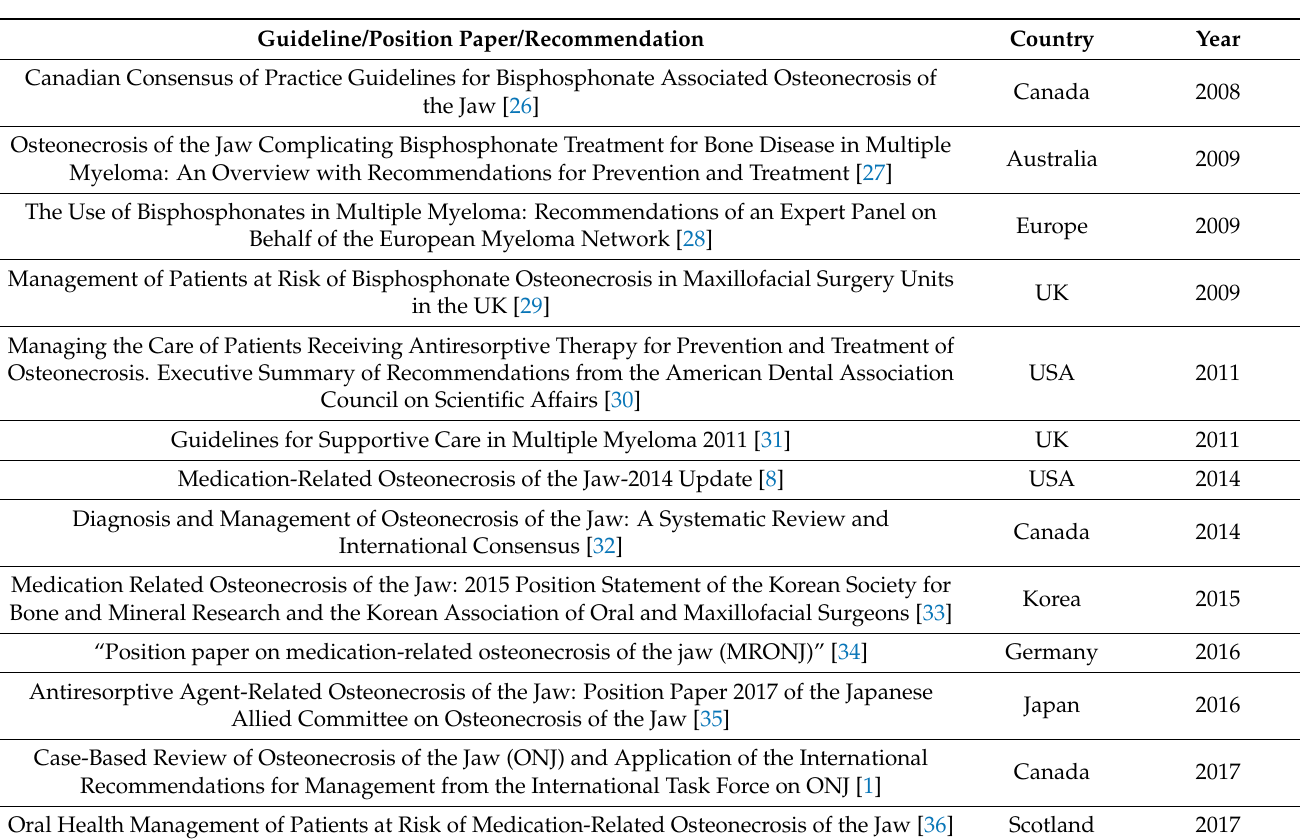
Table 1. Chronologic summary of the most common published guidelines/position papers/recommendations. Guideline/Position